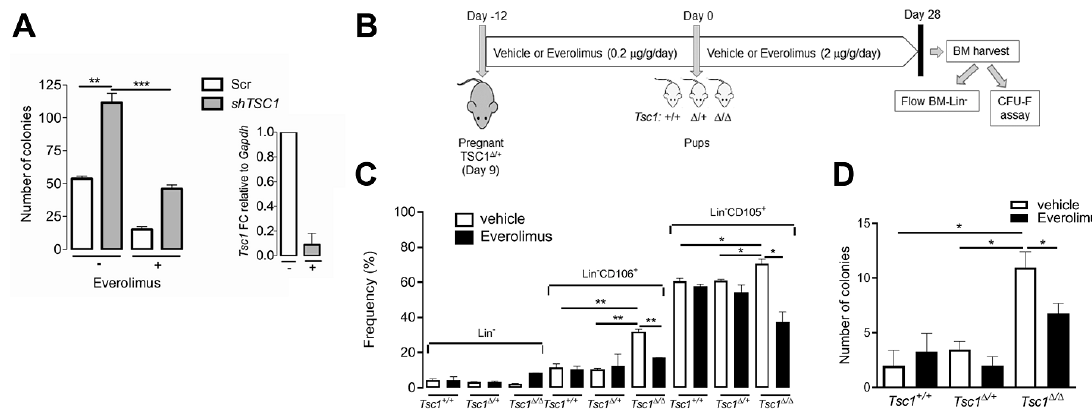
Figure 6. Everolimus inhibits the proliferative expansion of BM-Lin - cells and MSCs following Tsc1 inactivation. ( A ) CFU-F assay showing colony number in sh Tsc1- or Scr-transduced wt BM-MSCs with ( + ) and without (-) everolimus treatment (20 nM). Insert graph shows corresponding Tsc1 mRNA levels (fold change) in shRNA transduced cultures. ( B ) Experimental scheme for investigation of BM hyperproliferation in Tsc1 mutants following in vivo treatment with everolimus. ( C ) Cell population frequency, by flow cytometry of BM-Lin - cells immediately the following isolation from 28 day old pups with and without everolimus treatment. Lin - and Lin - CD106 + and -CD105 + populations are shown for each genotype. ( D ) CFU-F assay showing colony number of BM-Lin - MSCs of each genotype following in vivo administration of everolimus or vehicle controls. Panel A: Data show means ± SD, n = 3 per group. Panels C–D: Data show means ± SD, n = 3 animals per group. *, p < 0.05; **, p < 0.01; ***, p < 0.001.